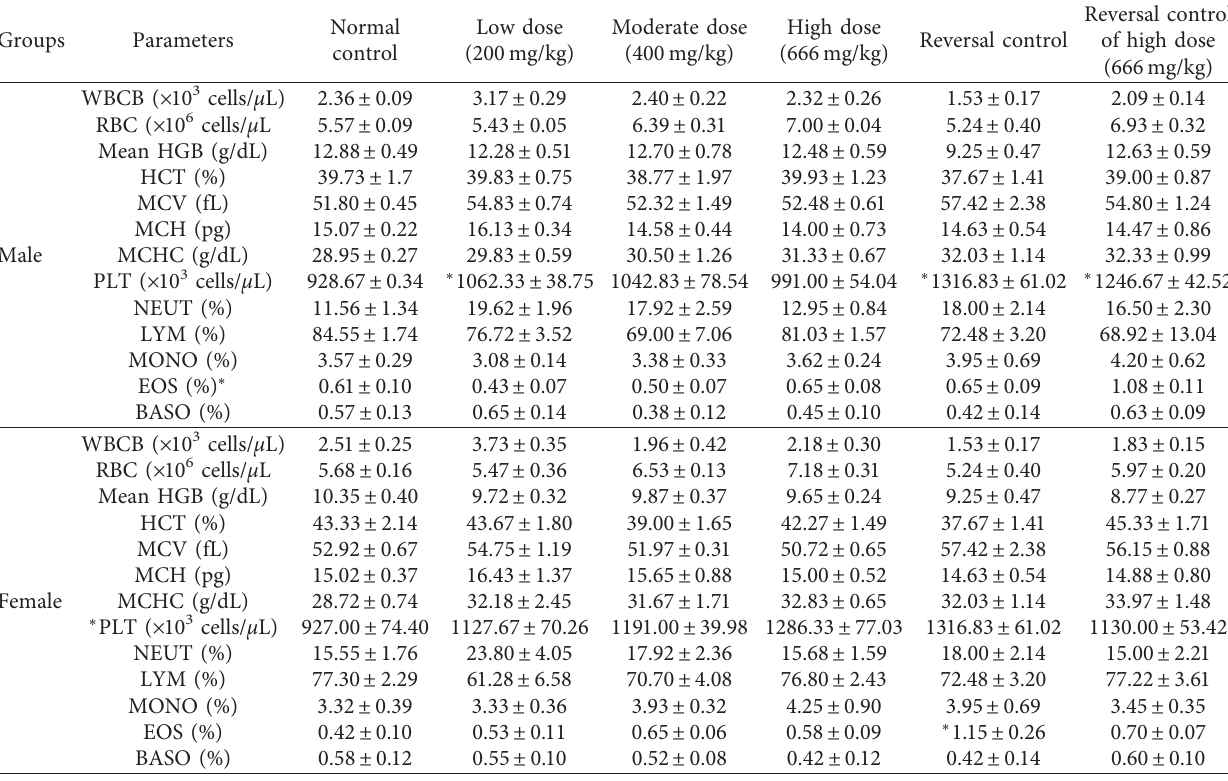
Table 1: Evaluation of hematological parameters in repeated dose oral subacute toxicity study of AND-2-HyP- β -CYD complex.